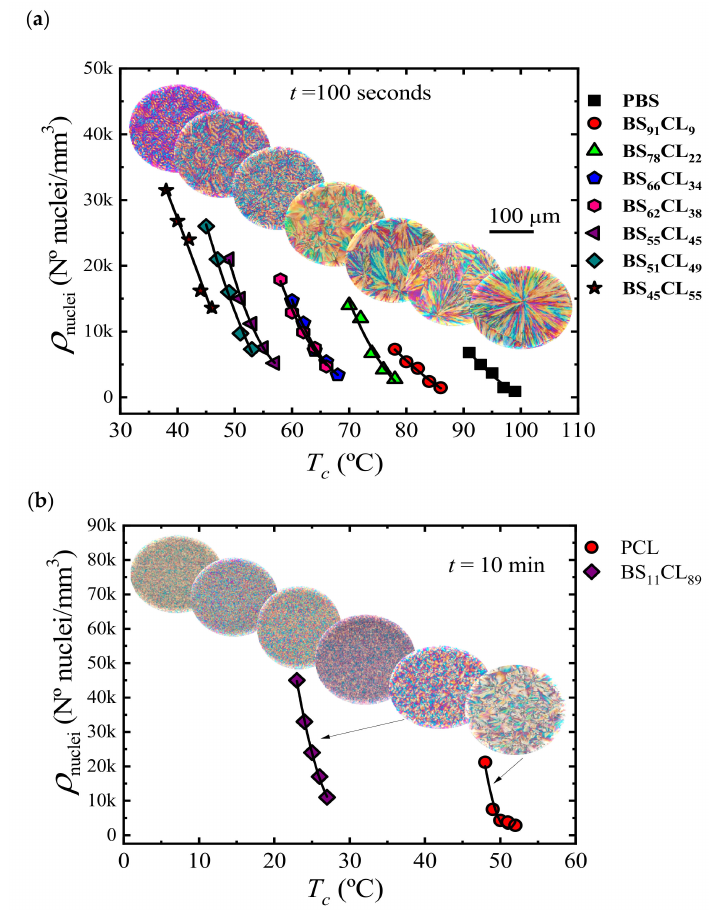
Figure 10. Nuclei density ( ρ nuclei) as a function of crystallization temperature ( T c ) at 100 s for MM W -PBS-rich ( a ) and at 10 min of isothermal crystallization for MM W -PCL-rich ( b ) compositions. The inserted images are PLOM micrographs of each composition that crystallized isothermally at ∆ T = 40 ◦ C. Data reported in ref. [38].